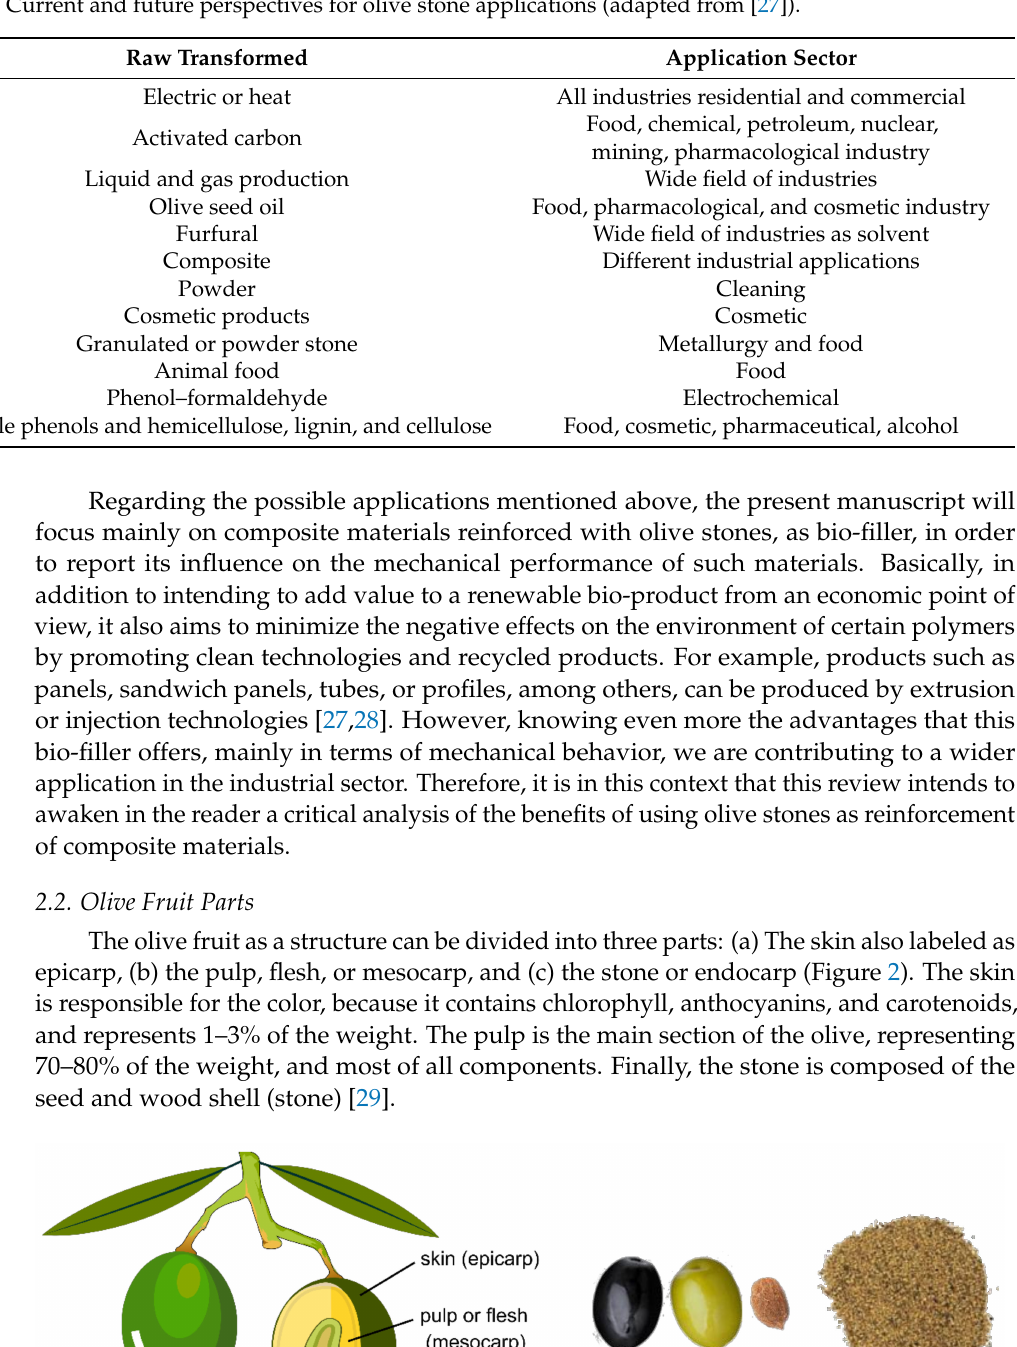
Table 1. Current and future perspectives for olive stone applications (adapted from [27]).